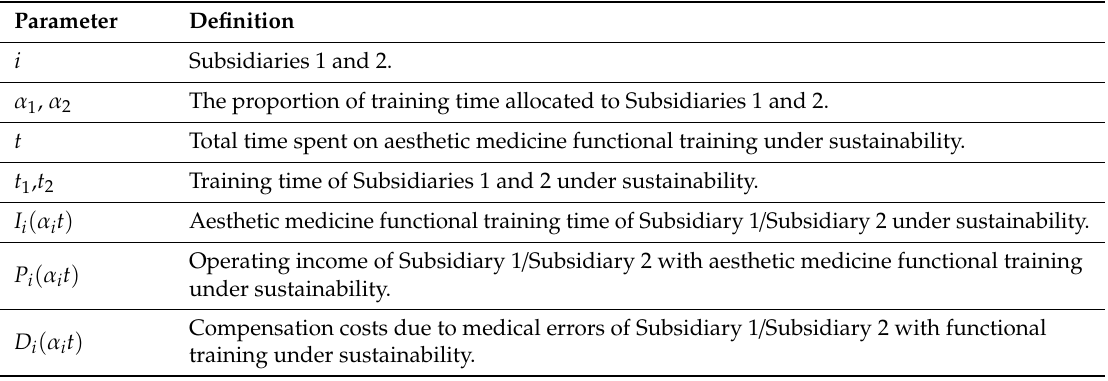
Table 1. Parameter symbol definition.